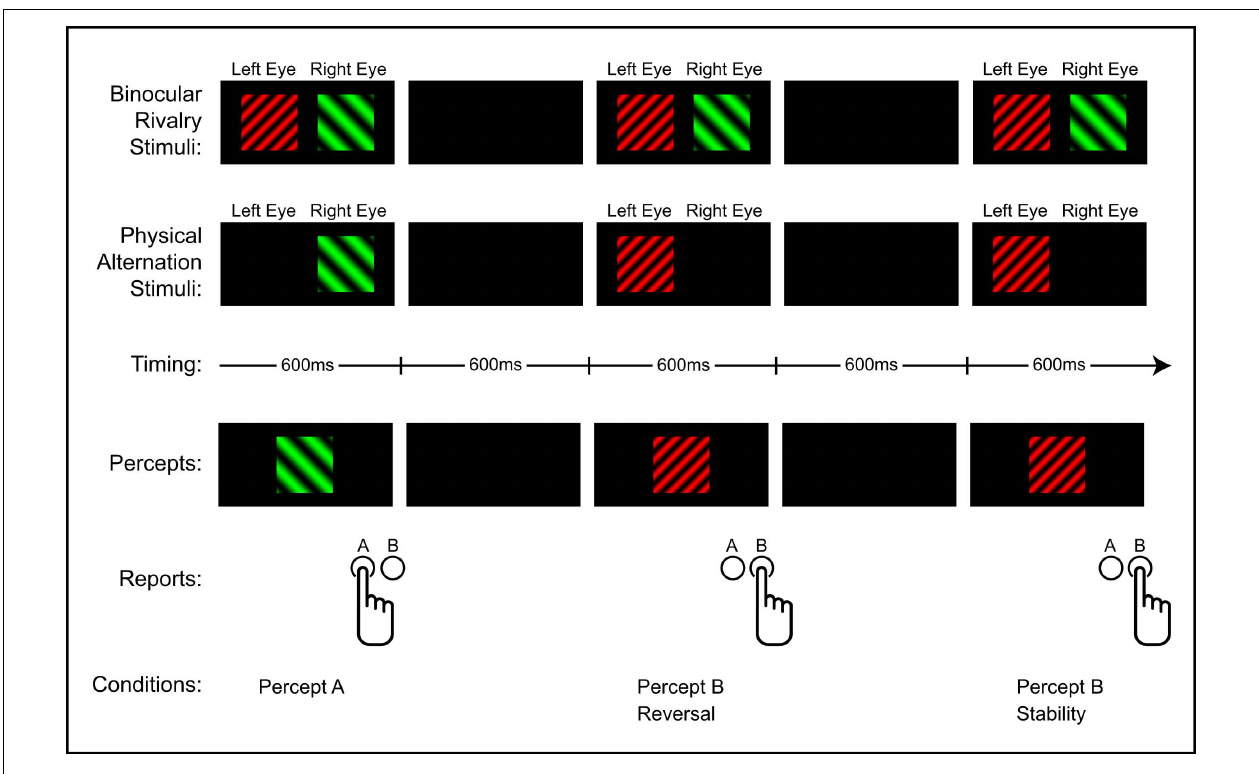
are made possible: endogenous percept A versus B; exogenous percept A versus B; endogenous reversal versus stability; exogenous reversal versus